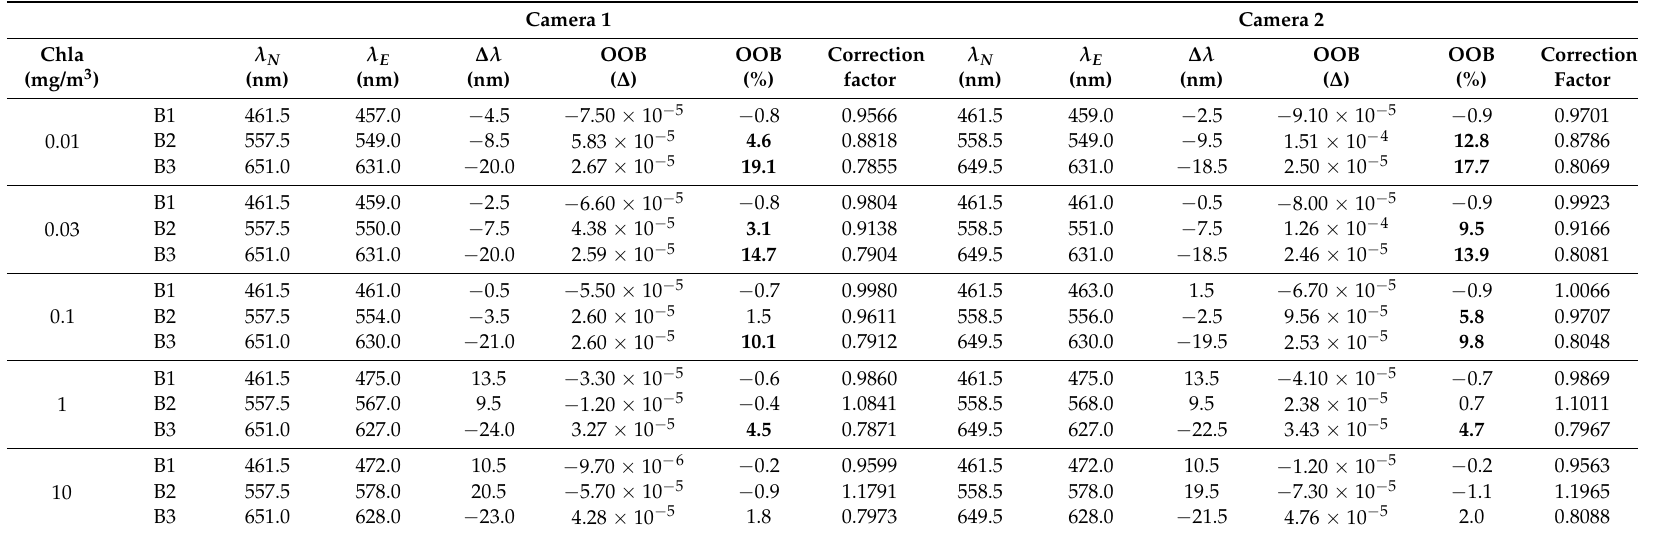
Table 2. The OOB and correction factor for the three visible bands (i.e., blue-B1, green-B2, and red-B3) of the two CZI cameras in the Case 1 water. OOB higher than 2% is highlighted as bold numbers. λ N and λ E denote the nominal center wavelength and the effective center wavelength, respectively. ∆ λ represents the shift of the effective central wavelength λ E relative to a nominal one λ N